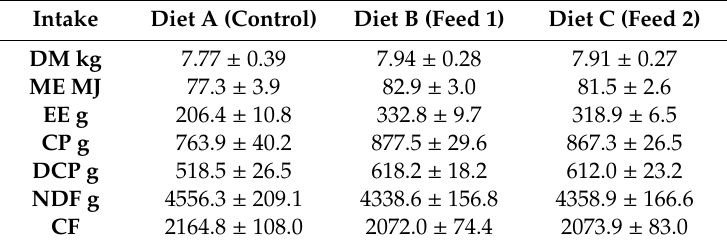
Table 4. Average daily dry matter, metabolisable energy and nutrient intakes ( ± s.d.) in each dietary treatment.